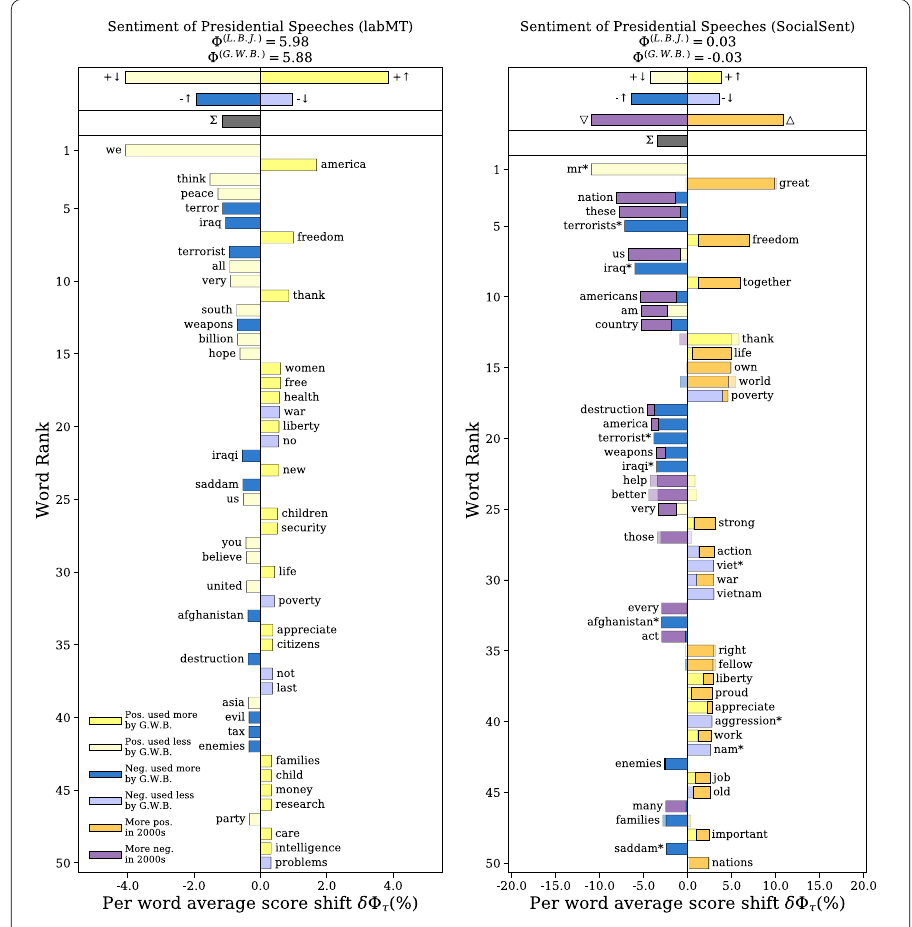
Figure 2 Word shift graphs of the sentiment of presidential speeches by United States Presidents Lyndon B. Johnson and George W. Bush. We display a basic word shift graph on the left, using the labMT sentiment dictionary [4] (one score per word); on the right is a generalized word shift graph, using the SocialSent decade-adapted sentiment dictionaries [35] (one score per word per decade). Word shifts show the top fifty contributing words to the difference in sentiment. Words to the left are those that contribute to Bush’s speeches being more negative than Johnson’s, while words to the right partly offset that negativity. Bars at the top show the overall sentiment difference and the effect of each type of word contribution on that difference. The bottom left corner includes a legend for interpreting the different types of contributions in the context of the presidential speeches. In the generalized word shift graph, words that are borrowing a score across decades are marked by an asterisk ( ∗ ). We use the center of each of labMT’s and SocialSent’s sentiment distributions as the reference scores: (cid:6) (ref) = 5 for labMT and (cid:6) (ref) = 0 for